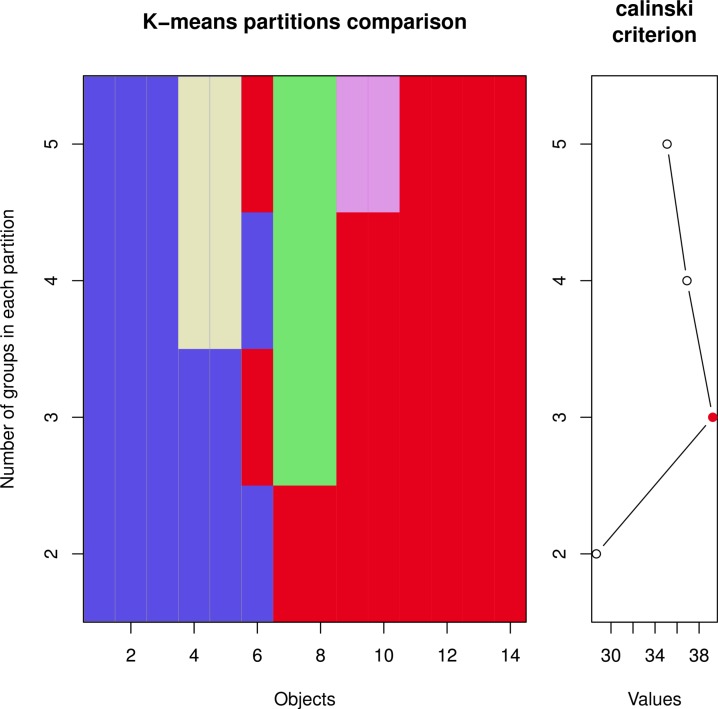
Estimation of the number of clusters using the Caliński-Harabasz index.